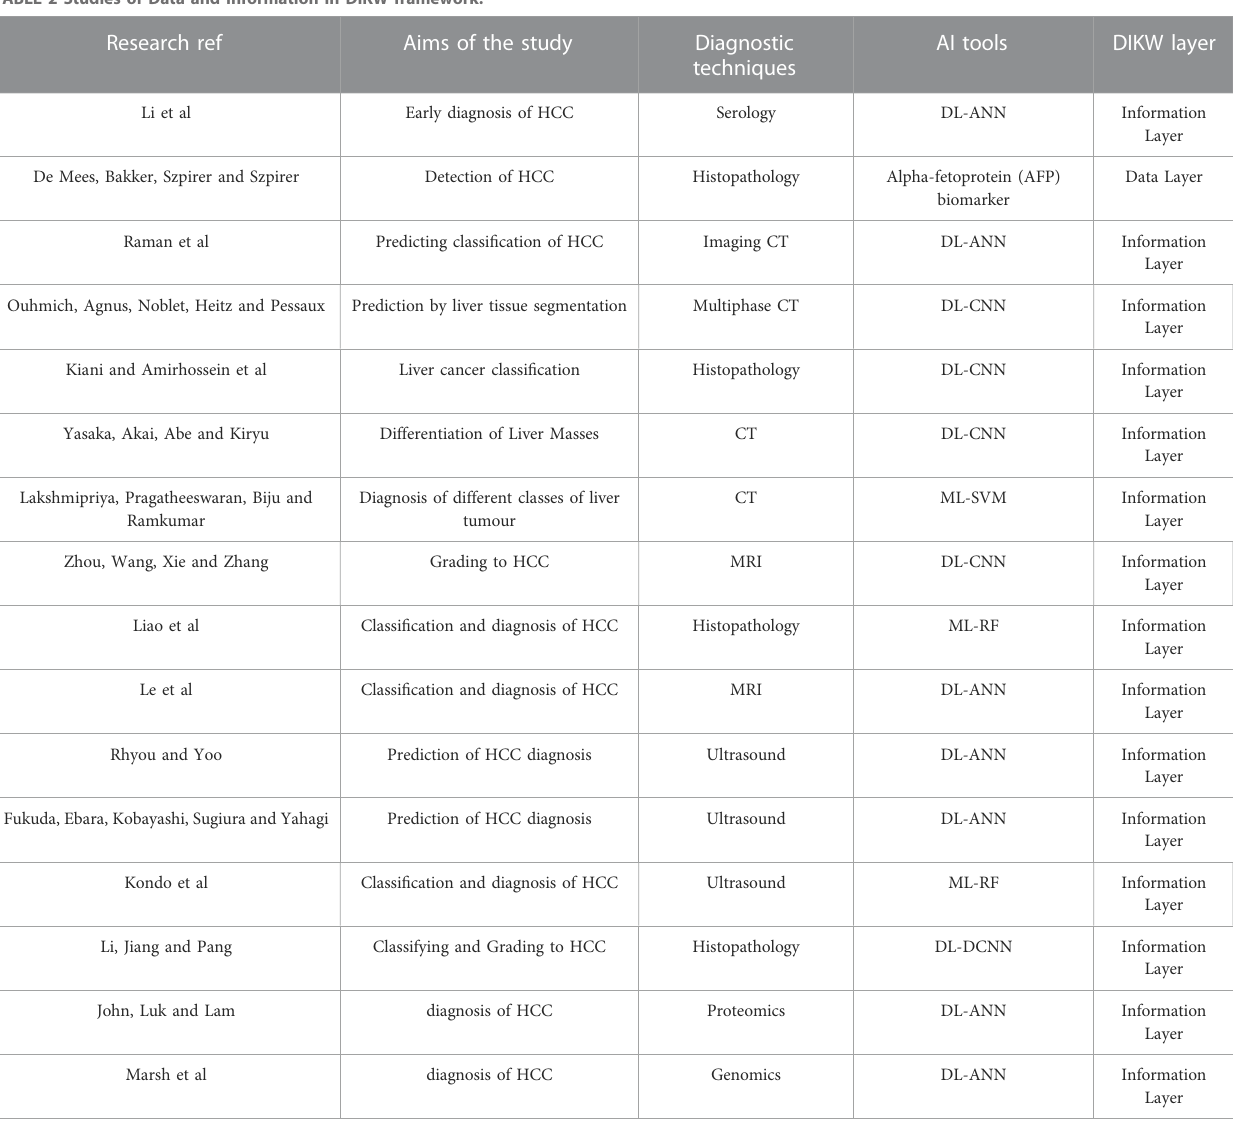
TABLE 2 Studies of Data and Information in DIKW